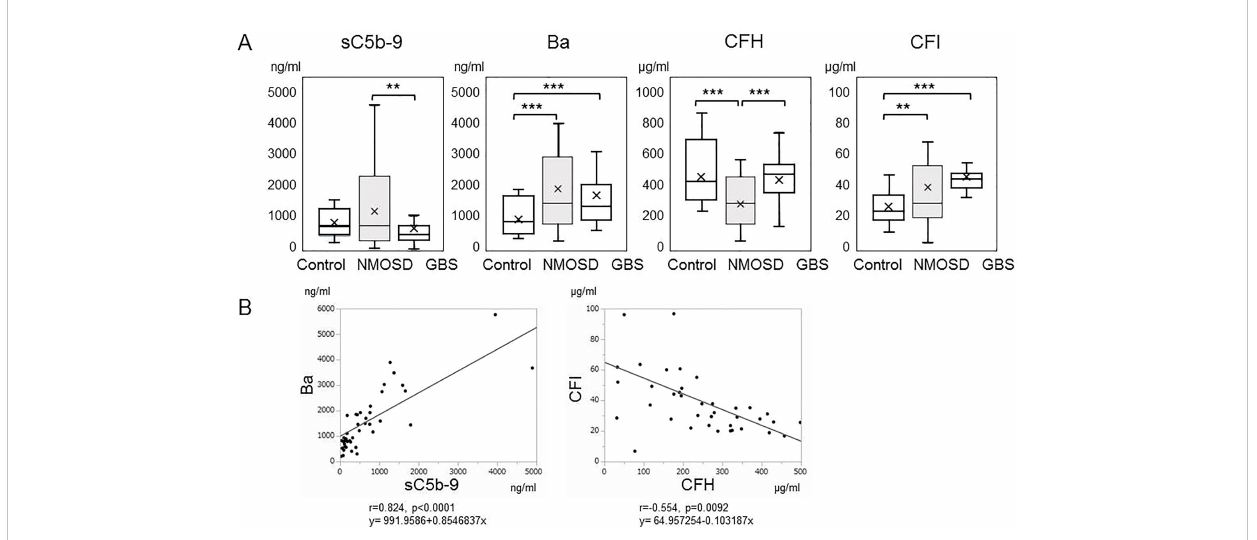
FIGURE 1 (A) Serum levels of complement markers in the acute phases of neuromyelitis optica spectrum disorders and Guillain-Barre ́ syndrome. Serum levels of sC5b-9, Ba, complement factor H, and complement factor I in the acute phases of neuromyelitis optica spectrum disorders and Guillain-Barre ́ syndrome, together with those of healthy controls, are shown by box plots. ** p < 0.01, and *** p < 0.001, ANOVA and Tukey-Kramer test as a post hoc test. (B) Correlation analysis of complement markers in the acute phase of neuromyelitis optica spectrum disorders. The relevance of serum levels of sC5b-9, Ba, complement factor H and complement factor I in the acute phase of neuromyelitis optica spectrum disorders were analyzed. Ba and sC5b-9 (r=0.824, p <0.00010), and complement factor H and complement factor I (r=-0.554, p =0.0092) showed positive and negative correlations,